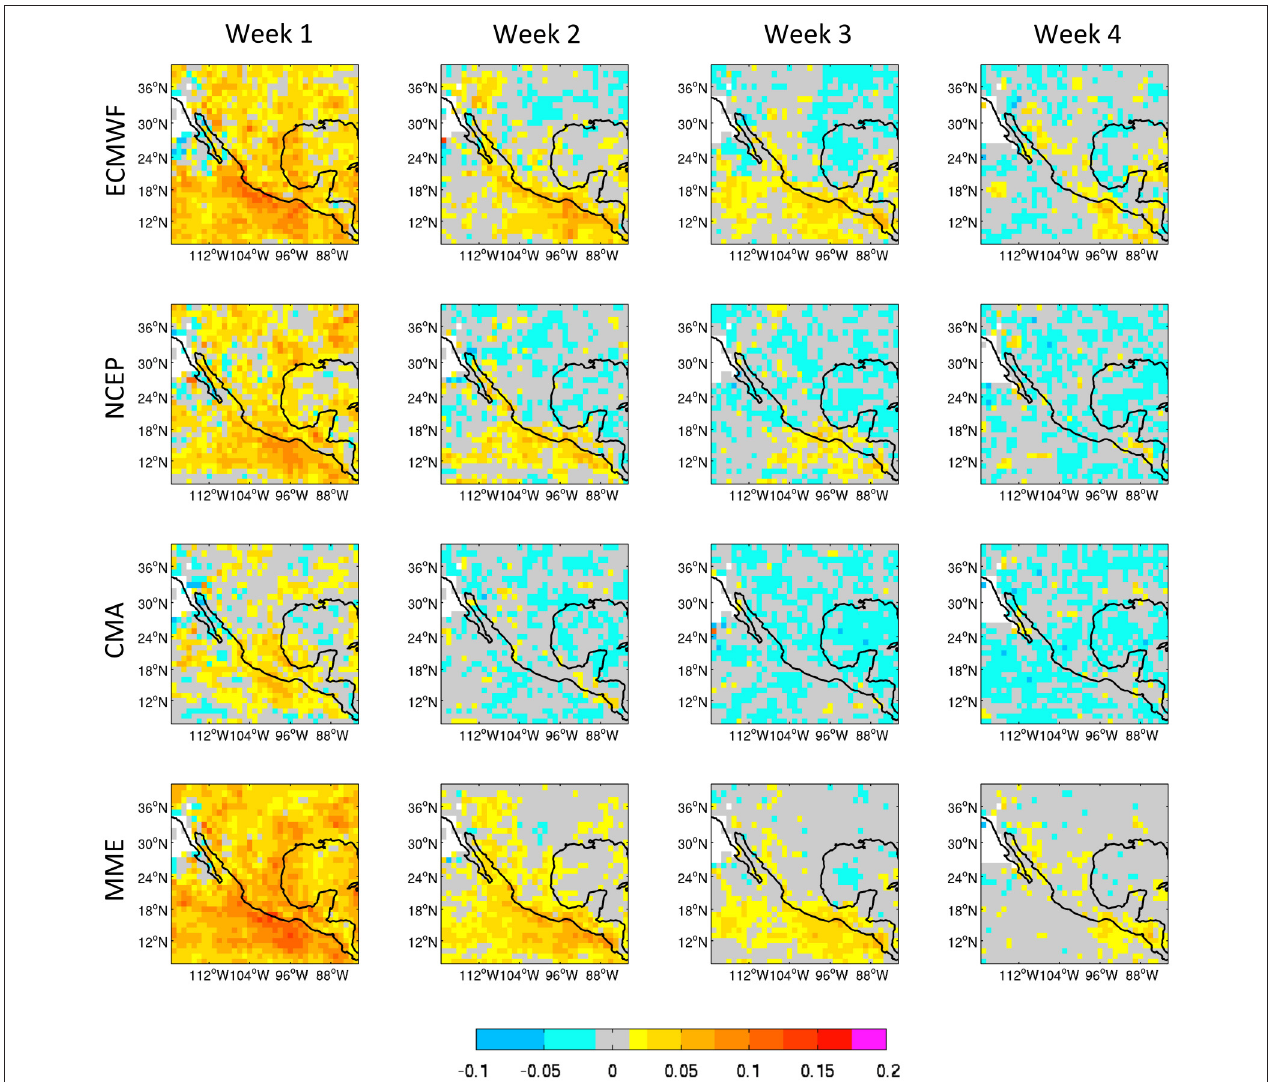
FIGURE 5 | Ranked Probability Skill Scores (RPSS) for ECMWF, NCEP, and CMA terciles precipitation forecasts as well as their MME for starts during the May-Aug season. The different columns correspond to different leads from 1 to 4